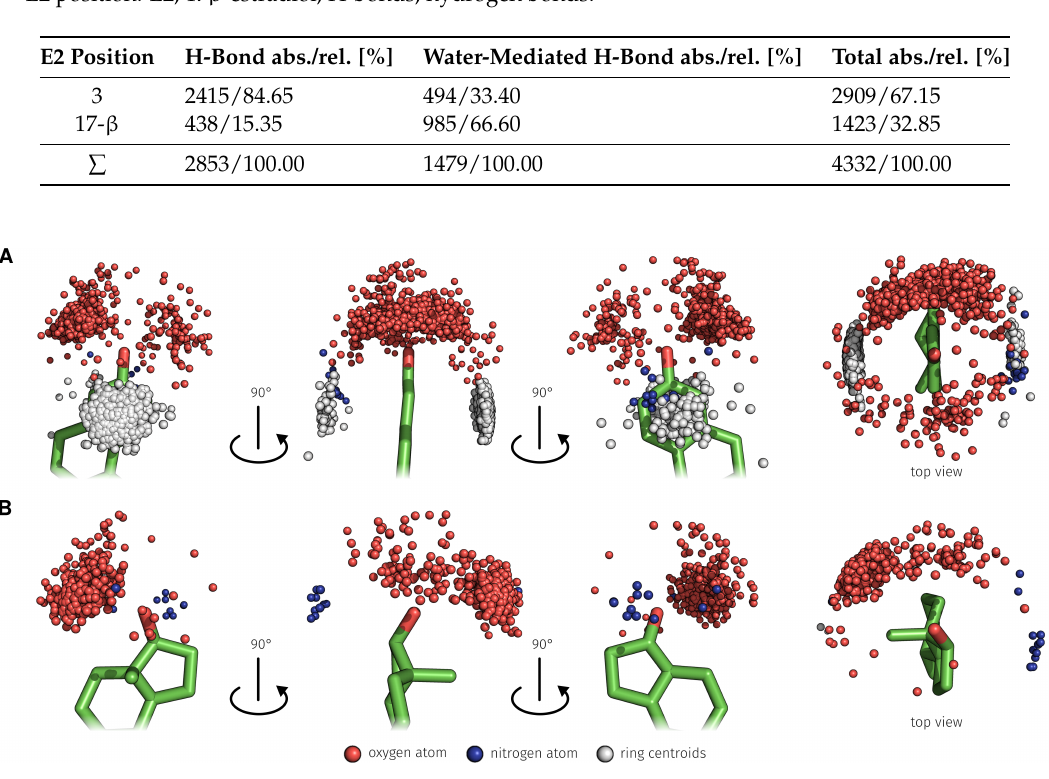
Figure 8. Distribution and different perspectives of the detected base interaction atoms during the 25 ns MD simulation that formed O–H · · · O (red atoms) and N–H · · · O (blue atoms) H-bonds and ring centroids representing the π -stacking interaction (gray pseudo atoms). ( A ) The focus is on the 3-position of E2. ( B ) The focus is on the 17- β -position of E2. E2, 17 β